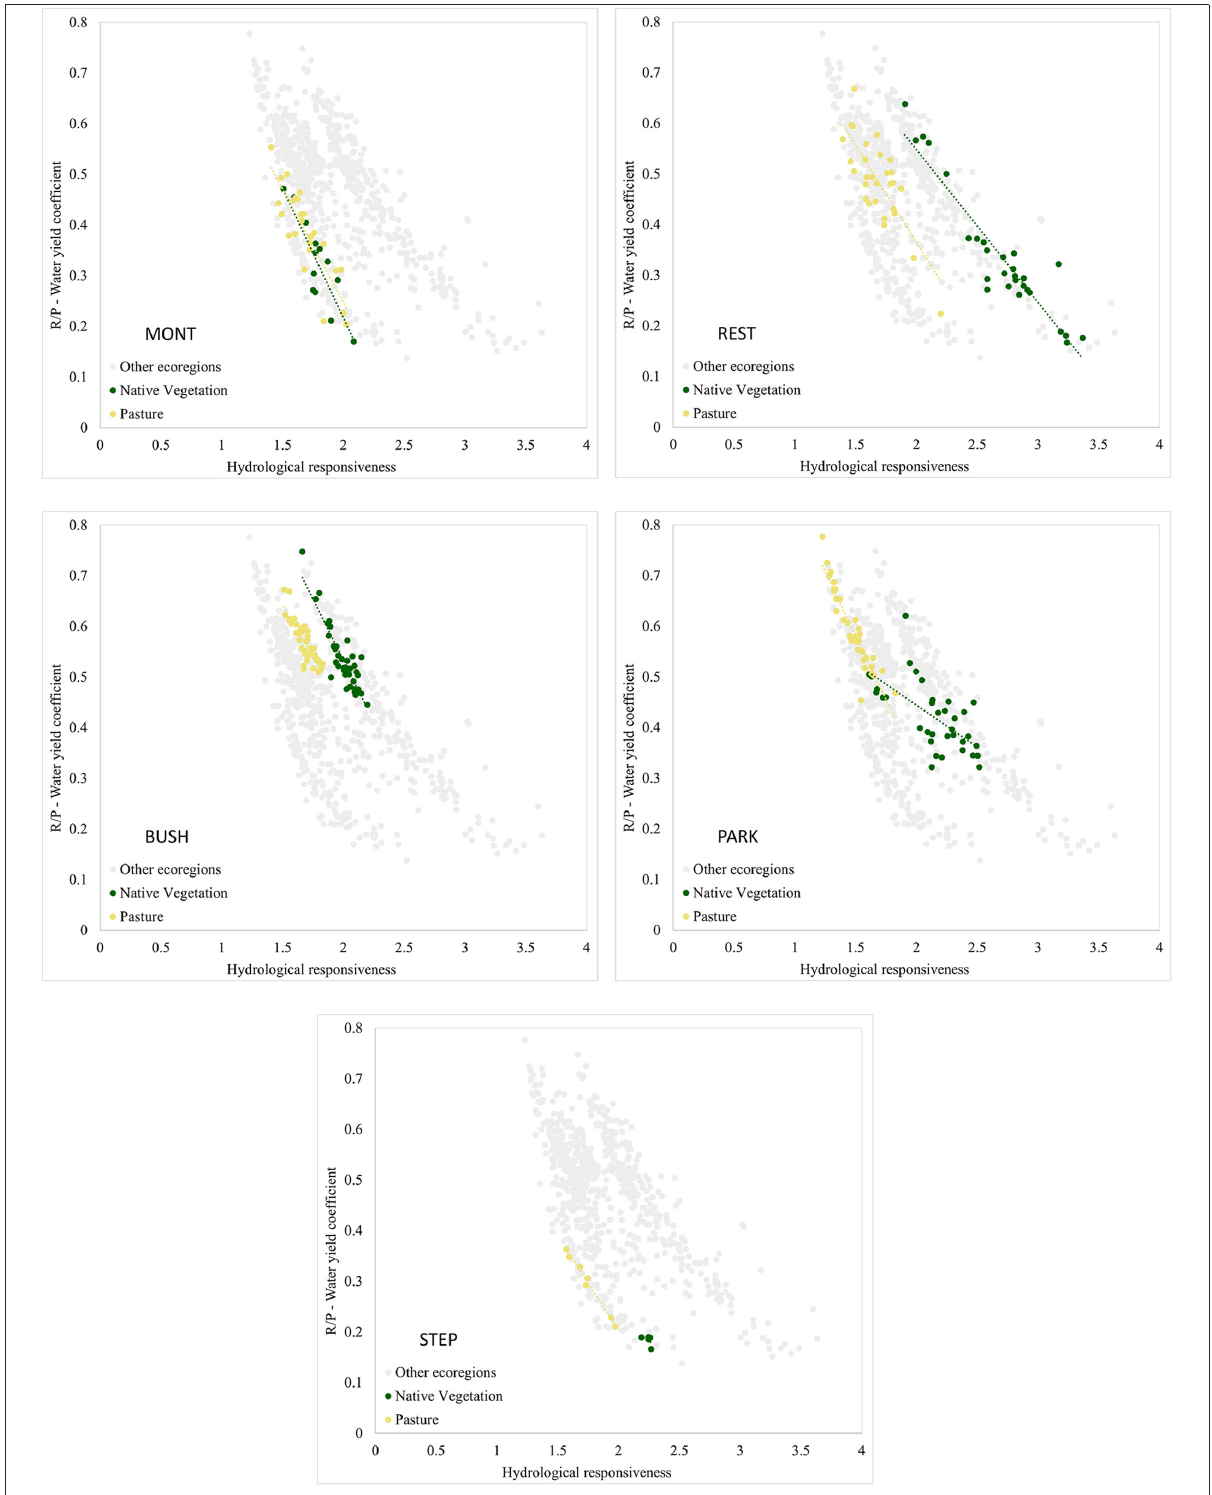
FIGURE4 Water yield ratio (R/P) according to the coefficient of hydrological responsiveness (m) for each land use-cover and ecoregion of the Atlantic Forest, Brazil. Gray points represent all ecoregions. REST, Arboreal restinga and mangrove; BUSH, Bushy grassland; DECI, Deciduous broadleaved forest; ECOT, Ecotone; EVER, Evergreen broadleaved forest; MIXE, Mixed needle-broadleaved forest; MONT, Montane and upper montane forest; OPEN, Open ombrophilous forest; PARK, Parkland savanna; SEMI, Semideciduous broadleaved forest; STEP, Steppe